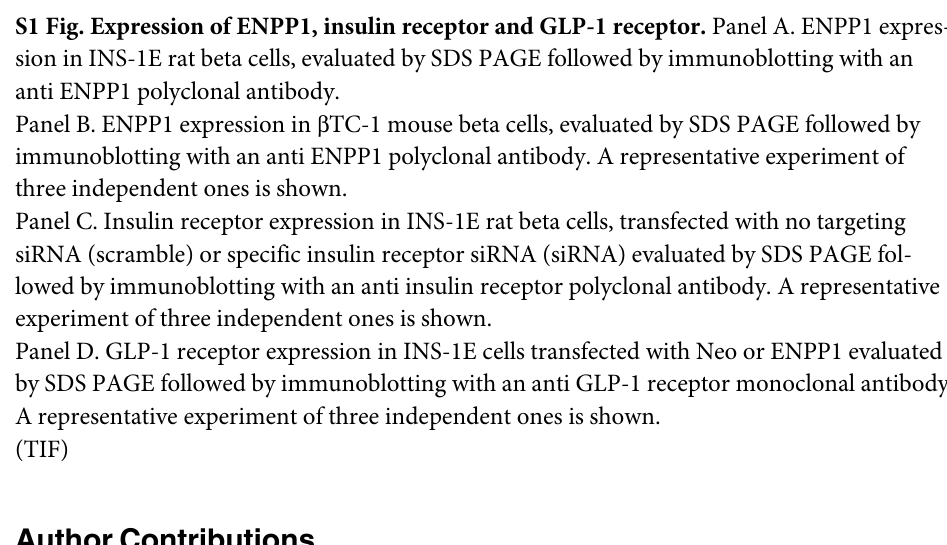
S1 Fig. Expression of ENPP1, insulin receptor and GLP-1 receptor. Panel A. ENPP1 expres- sion in INS-1E rat beta cells, evaluated by SDS PAGE followed by immunoblotting with an anti ENPP1 polyclonal